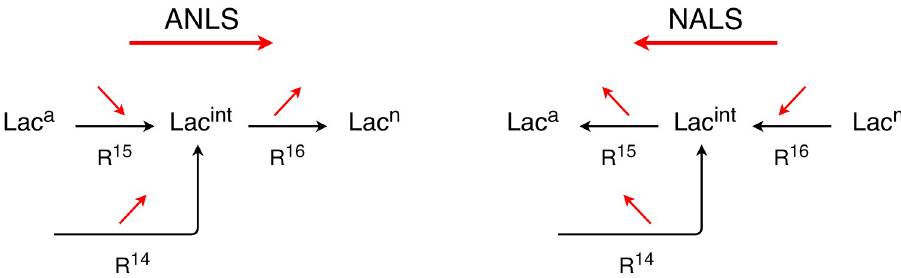
Fig 9. Schematic presentation of the changes in the rates R 14 , R 15 and R 16 in moderate exercise conditions compared with the normal ones. A schematic presentation of the changes in the net rates R 14 , R 15 and R 16 caused by the increased Lac concentration in serum in the ANLS (left) and NALS (right) cases at the moderate exercise scenario; in comparison to the NC case, R 14 increases in both ANLS and NALS, R 15 decreases in the ANLS case and increases in the NALS case, while R 16 increases in the ANLS case and decreases in the NALS